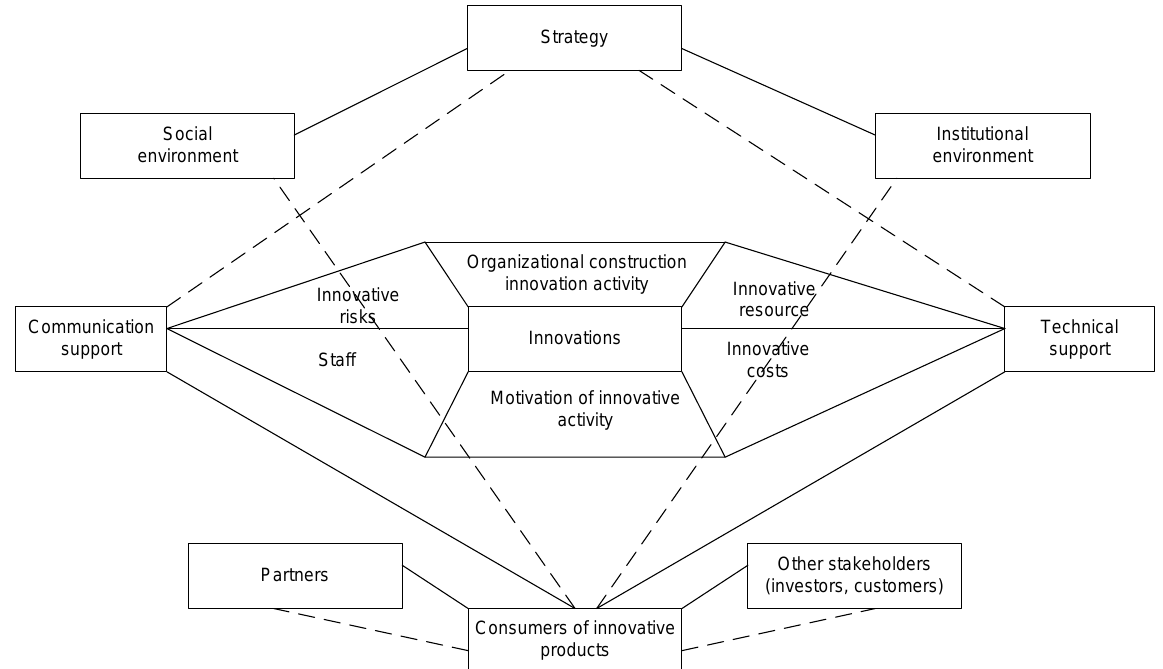
Fig. 1. Model of relationships within the open logistics innovation system of a pharmaceutical